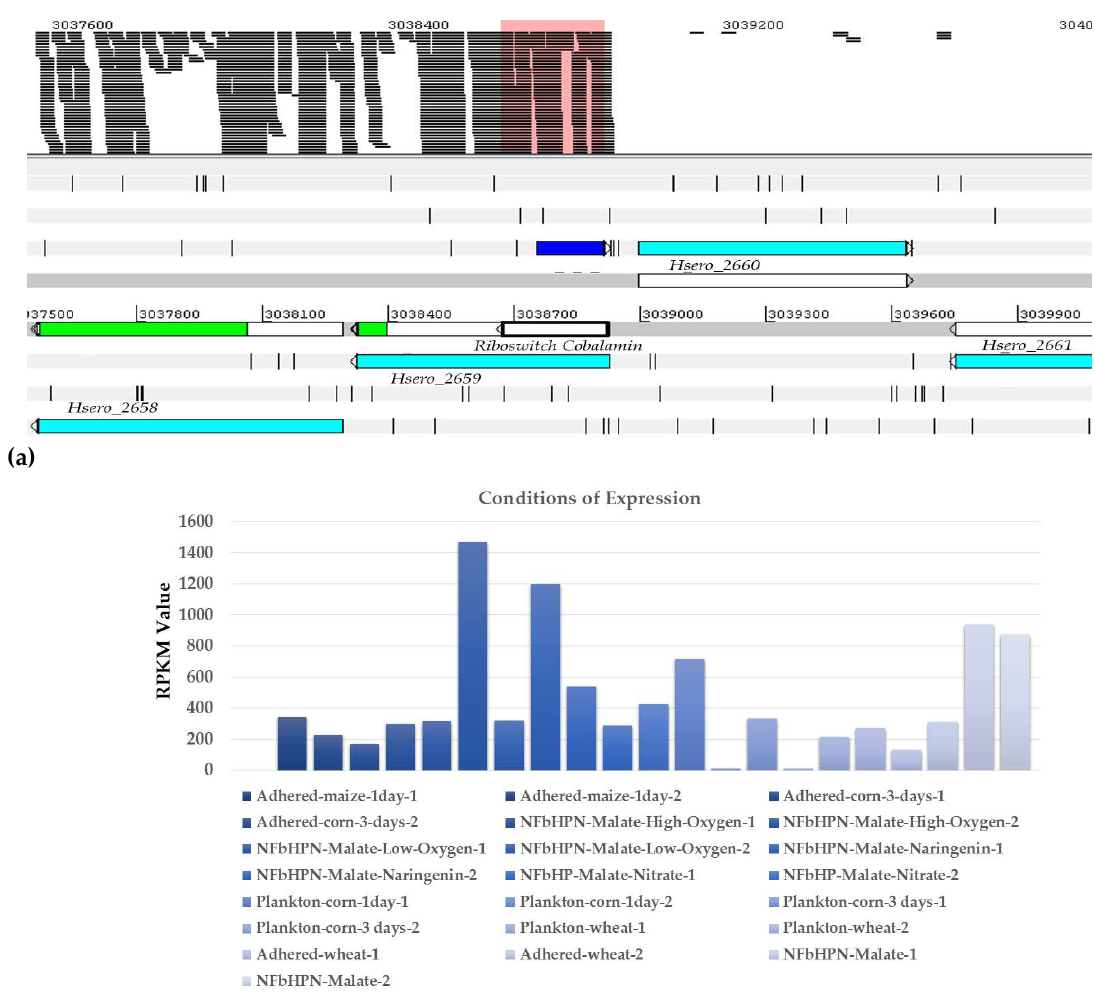
Figure 5. Visualization of the position and expression profile of the cobalamin ncRNA in the H. seropedicae genome SmR1. The sequence was located by means of the Artemis program. The readings are delineated by the pink rectangle ( a ). Levels of ncRNA cobalamin expression in RNA-seq assays in H. seropedicae SmR1. In the colored section, the 11 analyzed experimental conditions represented, where 1 and 2 represent d.a.i (days after inoculation). ( b ) The numbers represent the value of the gene expression in RPKM.